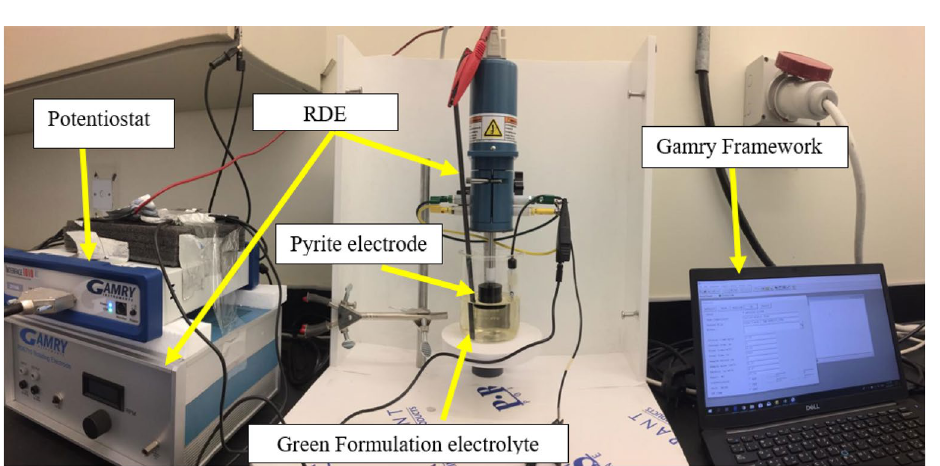
Figure 3. The Potentiostat and the rotating disc electrode